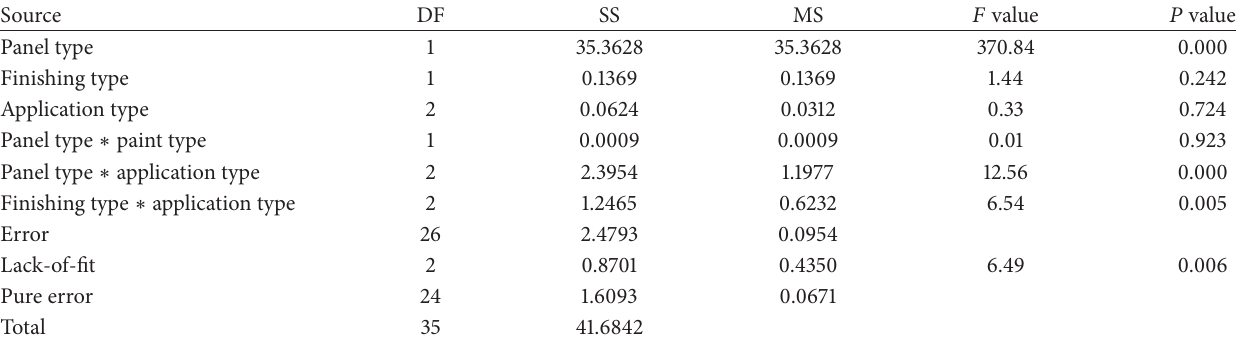
Table 4: The analysis of variance for adhesion strength of the samples.